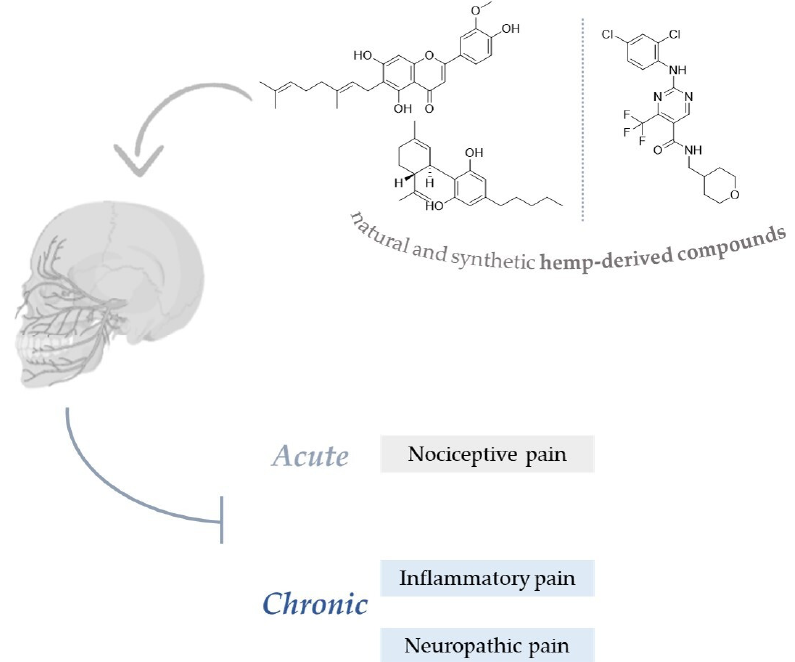
Figure 5. Pleiotropic mechanisms triggered by bioactive compounds of Cannabis sativa L. involved in the onset of inflammatory pain in TMJ.